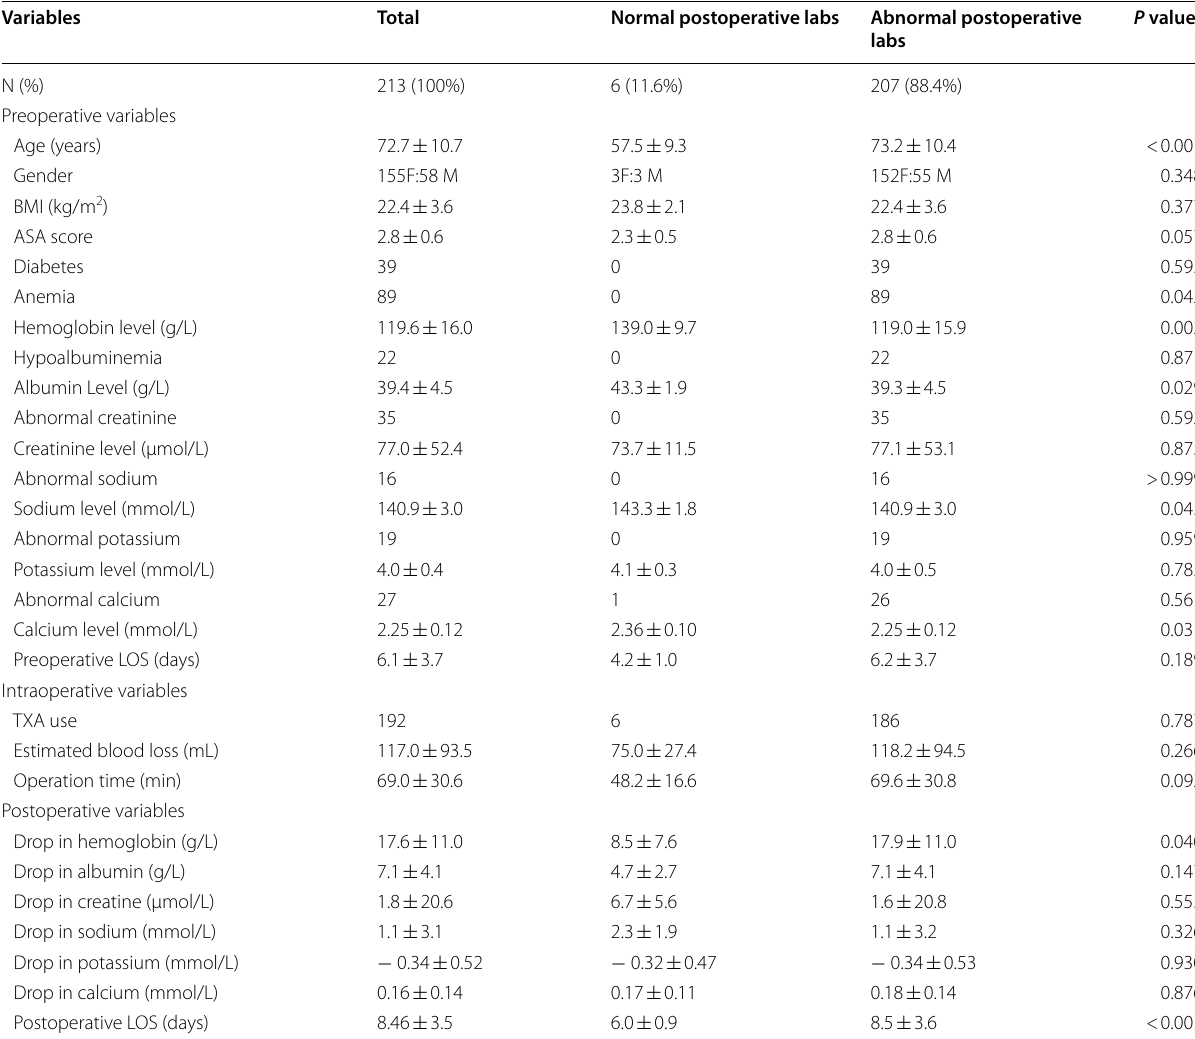
Table 1 Baseline characteristics of the study cohorts